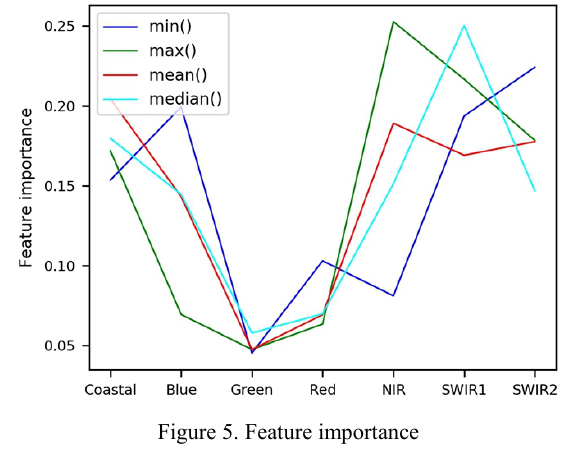
Figure 5. Feature